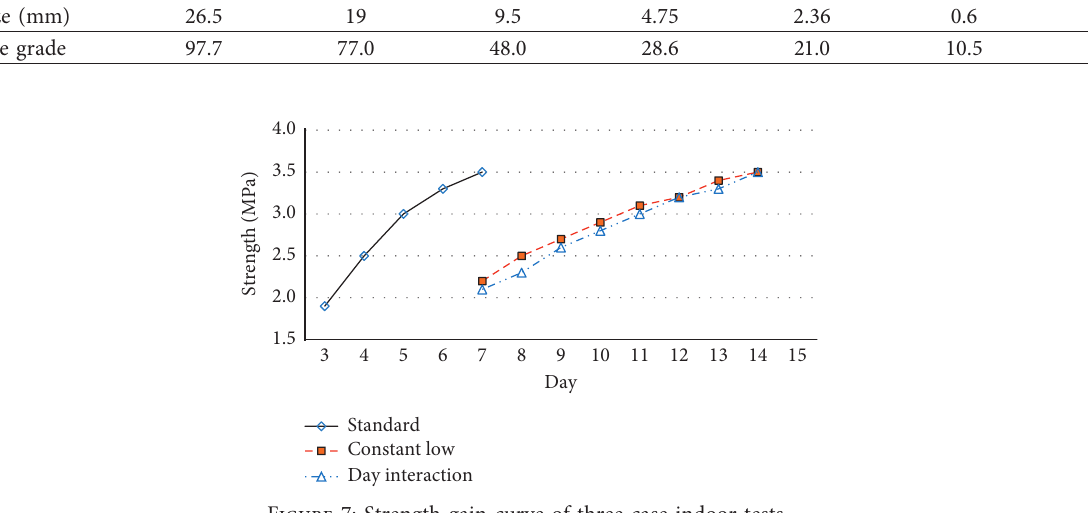
Figure 7: Strength gain curve of three case indoor tests.